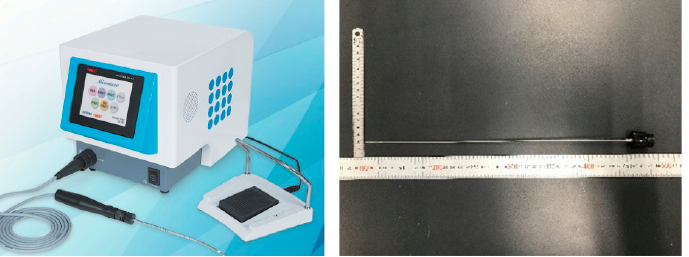
Figure 2. Microtaze AFM-712 generator and a coagulation needle electrode (Alfresa Pharma Co., Osaka, Japan).